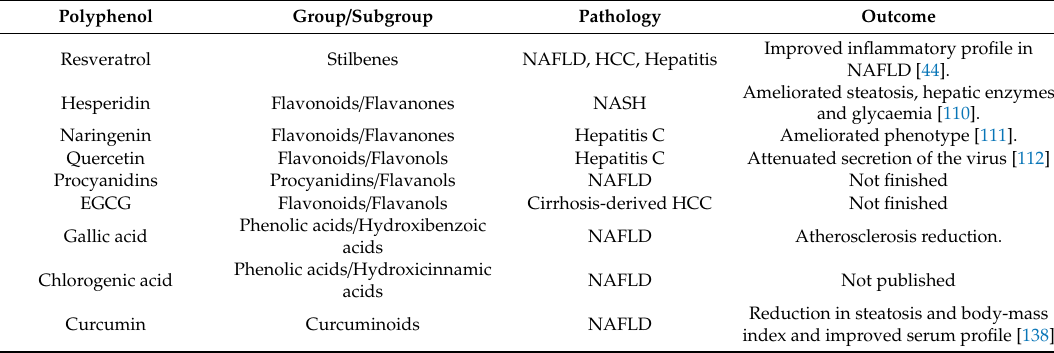
Table 1. Clinical trials testing polyphenols against liver